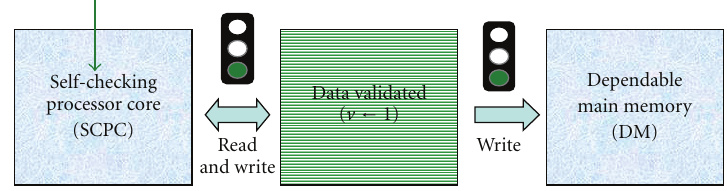
Figure 14: SCHJ relations in mode 10.